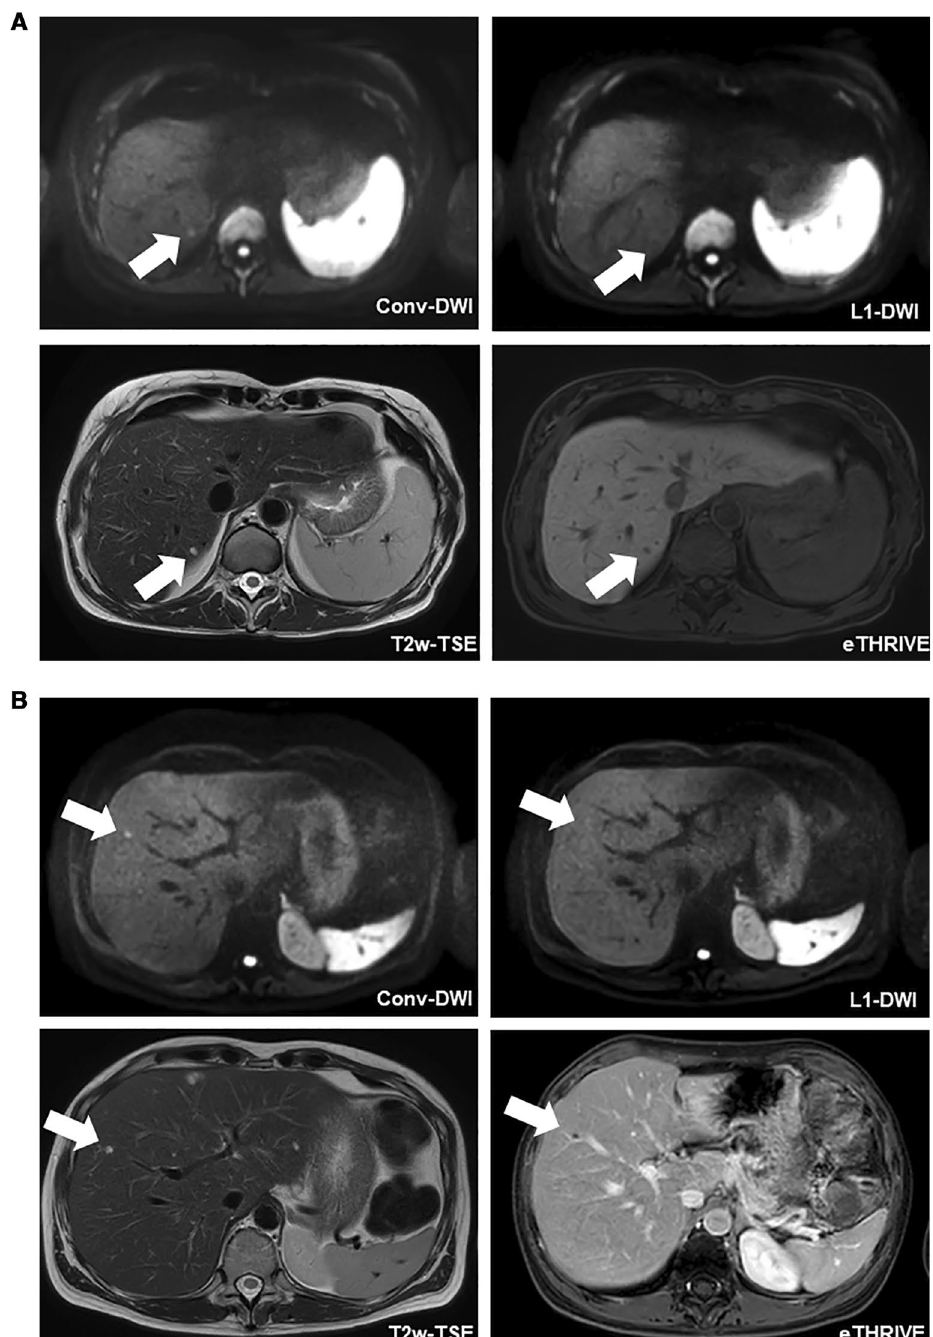
Figure 4. Patients of both groups with FLLs missed in L1-DWI. ( A ) 47-year-old female patient of group A who underwent a liver MRI for staging of colorectal carcinoma. In conv-DWI (upper row left), a FLL was detected in segment VII, that was not prospectively called on L1-DWI (upper row right). Taking all sequences from the routine MRI into account, e.g. T2-TSE (lower row left) and eTHRIVE (lower row right), this FLL corresponded to a cystic transformed metastasis. conv-DWI = single-shot EPI-based DWI with parallel imaging reconstruction. L1-DWI = single-shot EPI-based DWI with L1-regularized iterative reconstruction. T2w- TSE = T2-weighted turbo-spin echo. eTHRIVE = enhanced high-resolution fat-suppressed pulse sequence. ( B ) 46-year-old female patient of group B who underwent a liver MRI for staging of cervical carcinoma. In conv-DWI (upper row left), a FLL was detected in segment V, that was not prospectively called on L1-DWI (upper row right). Taking all sequences from the routine MRI into account, e.g. T2-TSE (lower row left) and eTHRIVE after injection of Gadobutrol (lower right right), this FLL corresponded to a thrombosed liver hemangioma. conv-DWI = single-shot EPI-based DWI with parallel imaging reconstruction. L1-DWI = single- shot EPI-based DWI with L1-regularized iterative reconstruction. T2w-TSE = T2-weighted turbo-spin echo. eTHRIVE = enhanced high-resolution fat-suppressed pulse